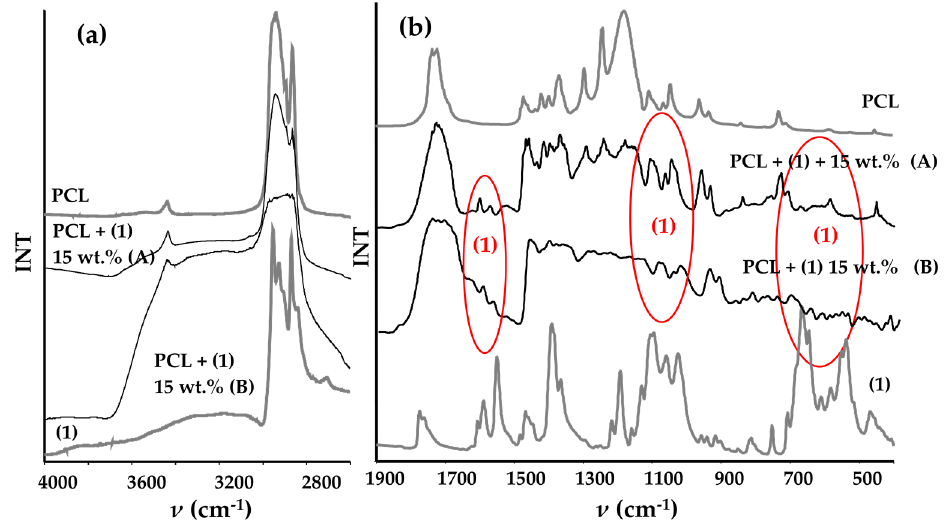
Figure 8. IR spectra registered in the ranges 2600-4000 cm − 1 ( a ) and 400-1900 cm − 1 ( b ) of PCL + ( 1 ) 15 wt.% composite samples before ( a ), and after ( b ) the photocatalytical experiment, during which they were immersed in the MB solution for 140 h. Composite spectra are compared with the PCL and ( 1 ) IR spectra (the locations of the bands characteristic for the ( 1 ) micrograins are marked in red). Table 4. MB solution decolorization percentages.